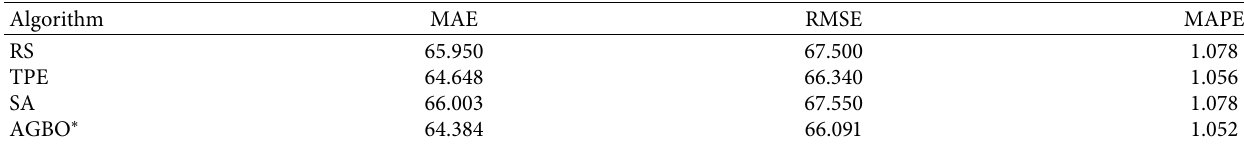
Table 2: The results of parameter identification with the loss function of mean square